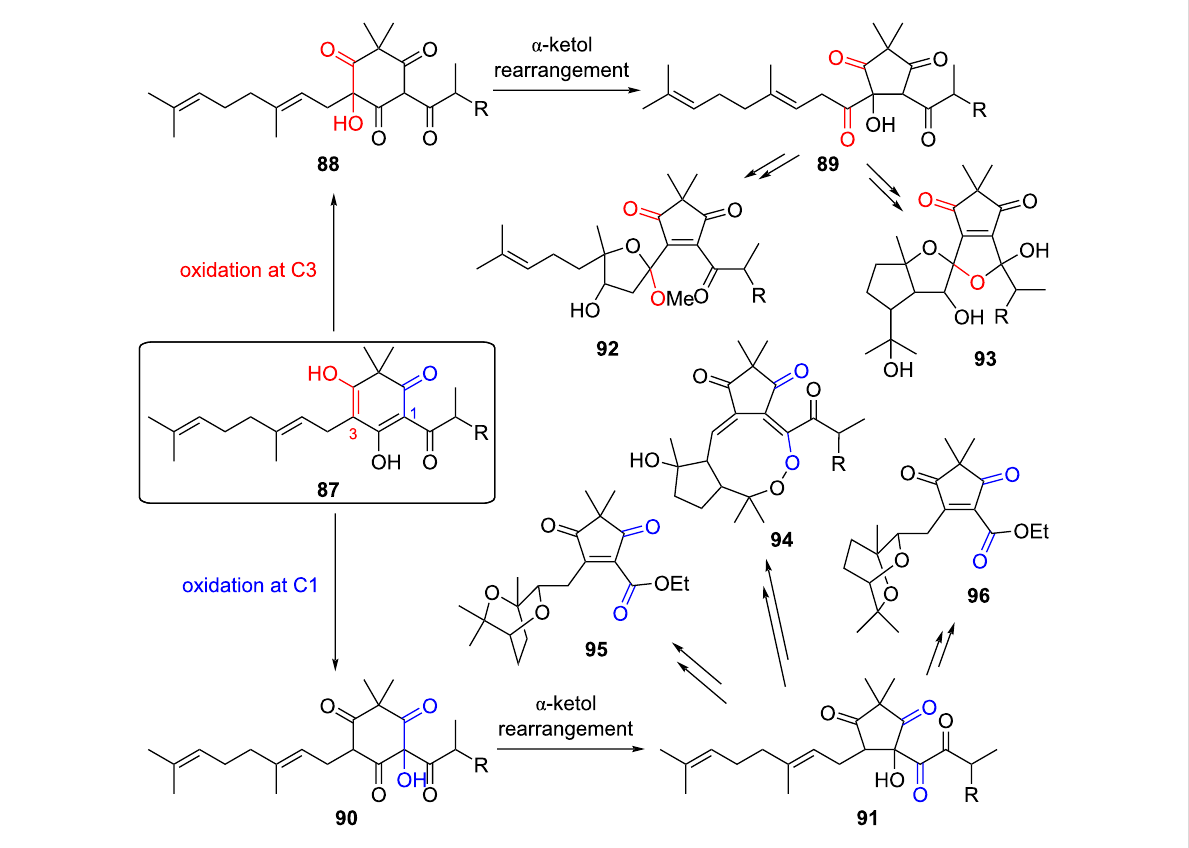
Figure 17: Proposed biosynthetic pathway converting acylphloroglucinol ( 87 ) to isolated elodeoidins A–H 92 – 96 . Oxidation at C3 followed by α -ketol rearrangement is believed to give rise to 92 and 93 , while a similar sequence at C1 is proposed to yield 94 – 96 . R = Me or Et.